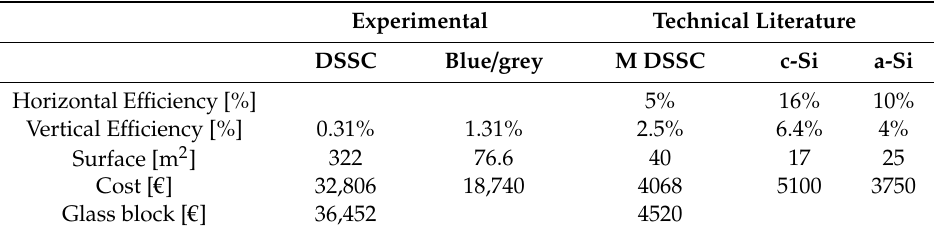
Table 1. Main parameters for 1.0 kWp vertical integrated